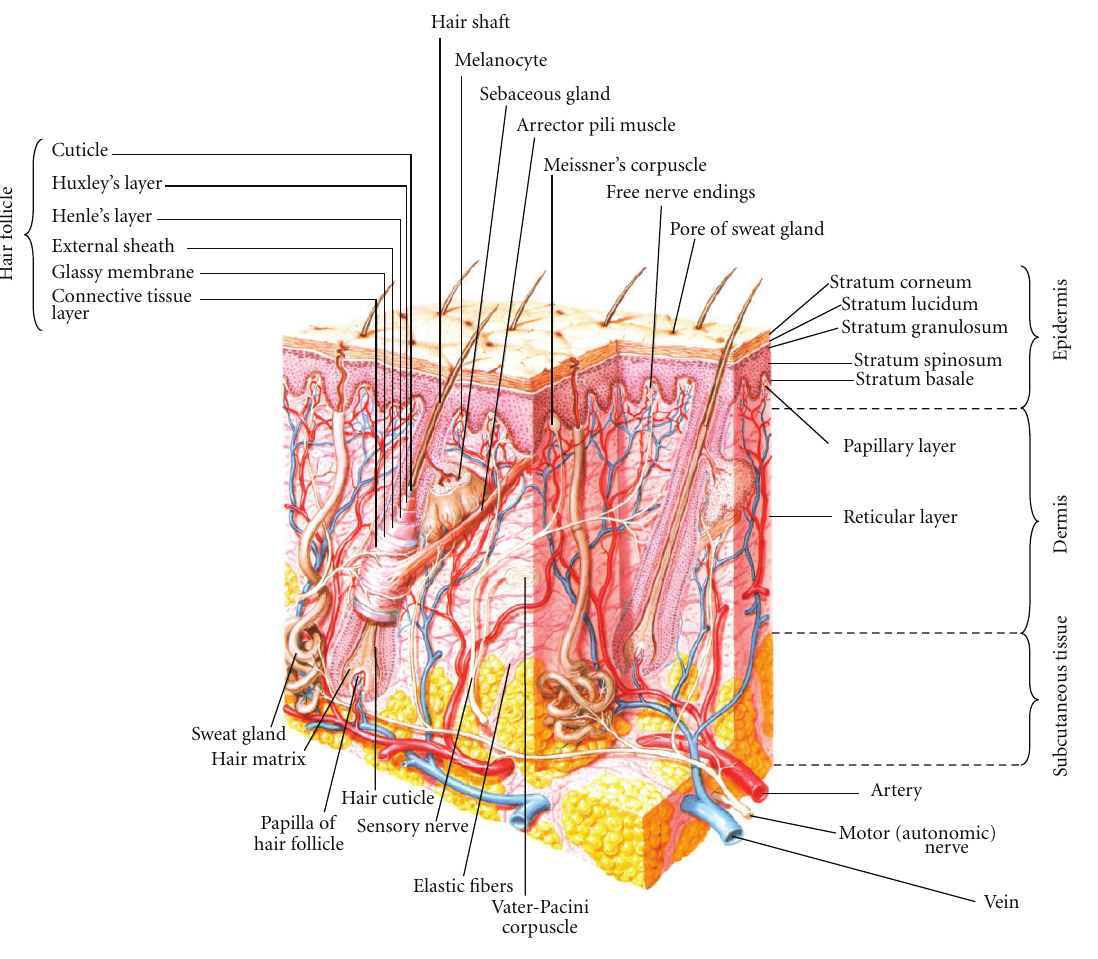
Figure 1: Skin structure